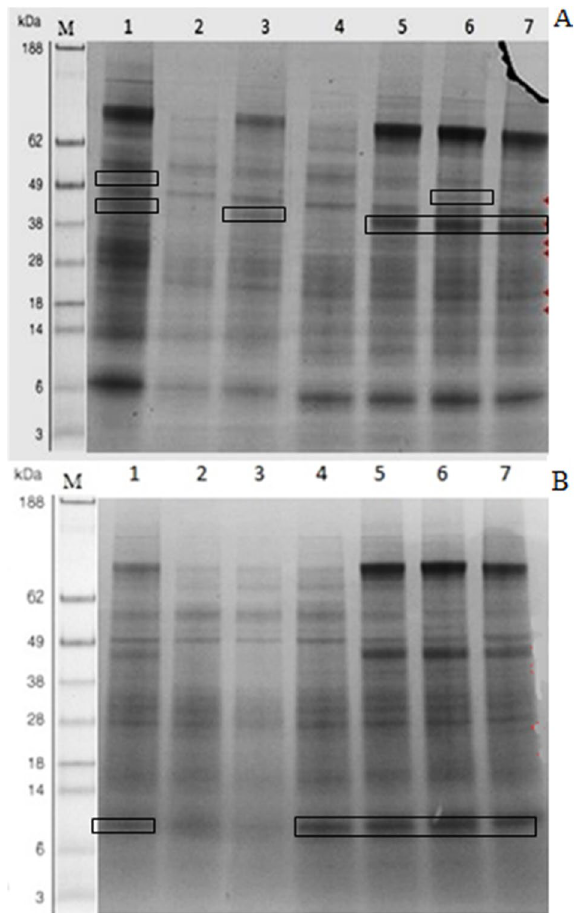
Figure 5. Effect of seed treatments with J. mimosifolia extract and control formulations on SDS-PAGE protein profiles of maize leaves from plants with stems infected with F. verticillioides . ( A ) Pot experiment, ( B ) Field experiment. Protein profile of maize leaves from 2nd year of experiment for both pot and field experiments. Encircled lanes indicate the induced protein bands. ( A ) Lane 1 = ½ (Jm + Mef) + Fv, Lane 2 = Fv, Lane 3 = Control, Lane 4 = Mef + Fv, Lane 5 = SA + Fv, Lane 6 = Jm + Fv, Lane 7 = ½ (Jm + SA) + Fv. ( B ) Lane 1 = Jm + Fv, Lane 2 = Control, Lane 3 = Fv, Lane 4 = Mef + Fv, Lane 5 = ½ (Jm + SA) + Fv, Lane 6 = ½ (Jm + Mef) + Fv, Lane 7 = SA + Fv. See Table 1 for